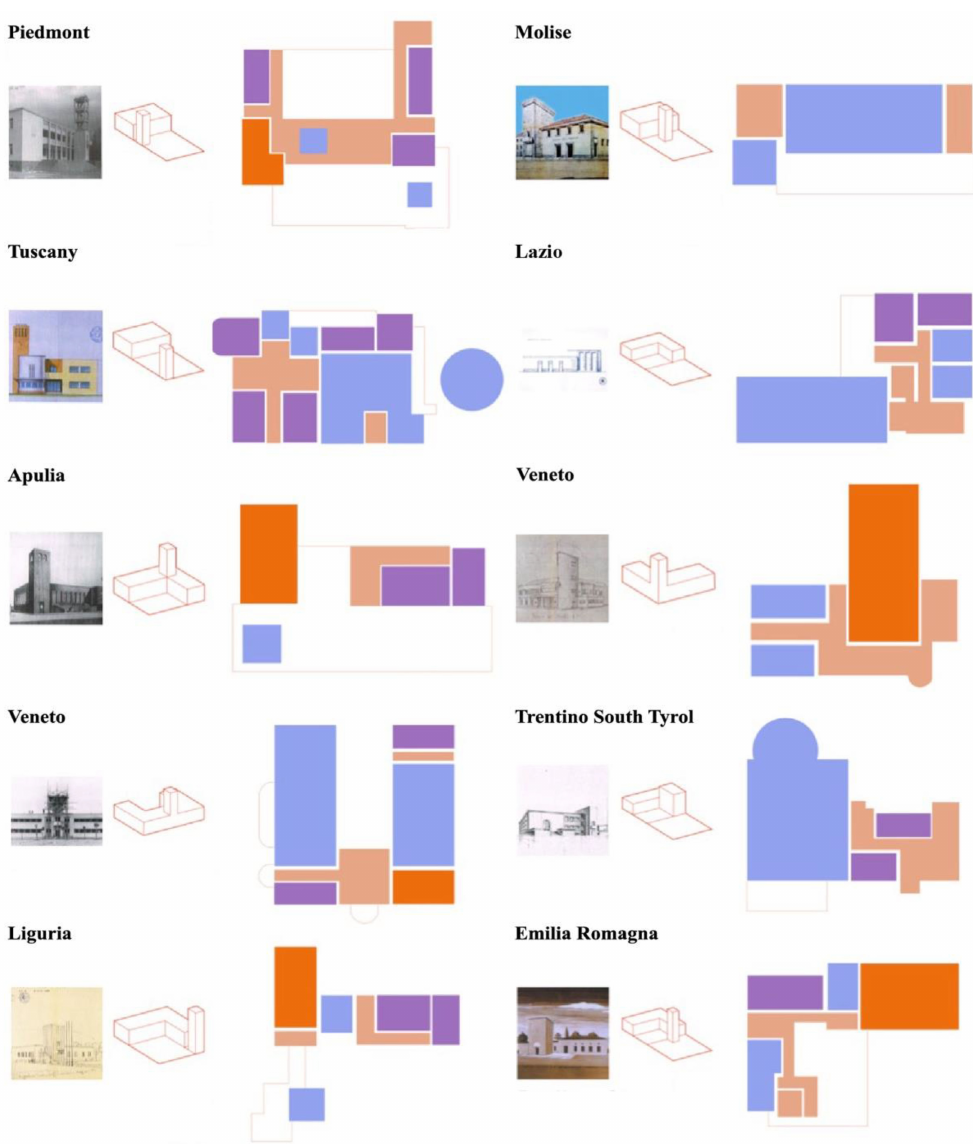
Figure 9. Replicability of the model applied to a sample of